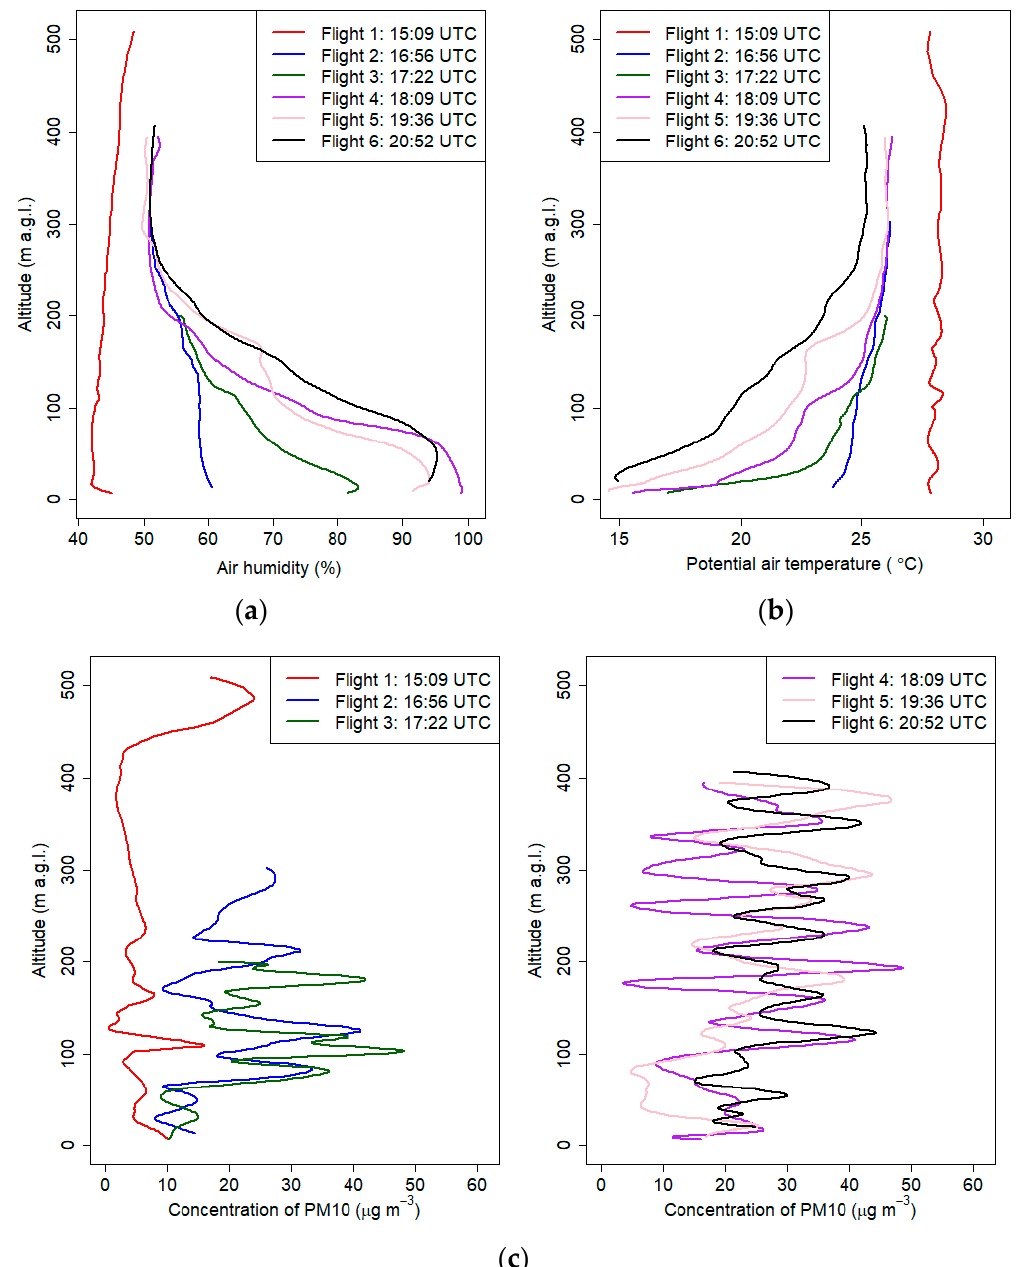
Figure 9. Vertical profiles of relative humidity ( a ), potential air temperature ( b ) and PM 10 concentration ( c ) on 18 September 2018 from 15:00 UTC to 21:00 UTC.